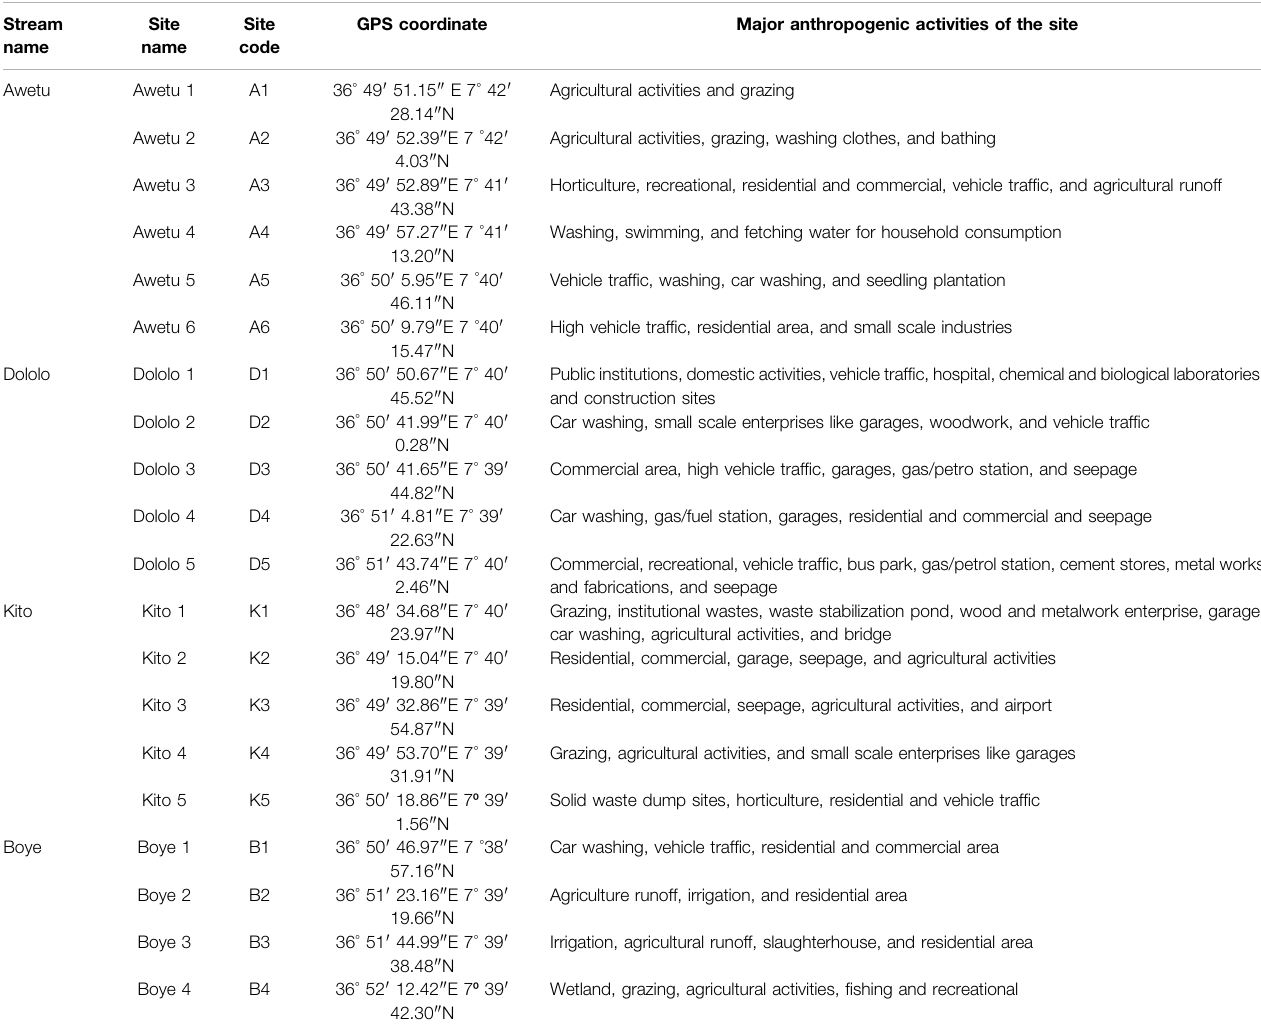
TABLE 1 | Sampling stations and their code, GPS coordinates, and major anthropogenic activities in the Awetu watershed